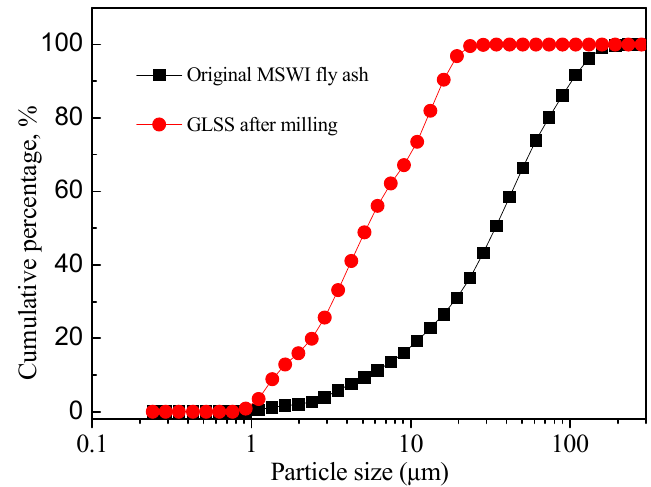
Figure 1. Particle size distributions of the original MSWI FA and GLSS after milling.